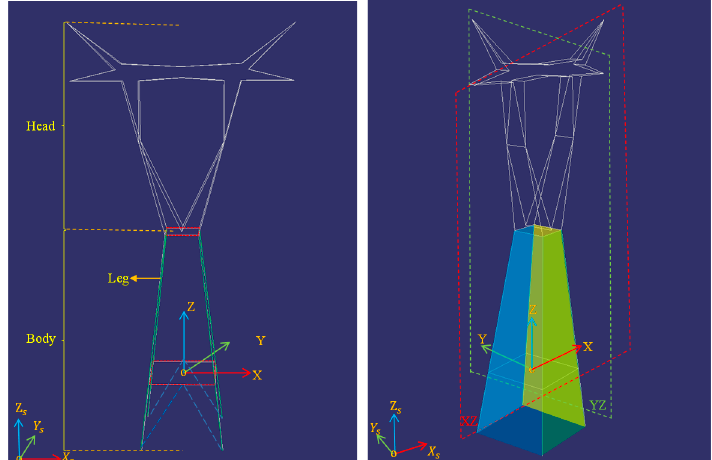
Figure 2. The structure of pylons. ( a ) The two divided parts of the pylon; ( b ) the four side planes and two symmetry planes of the pylon.